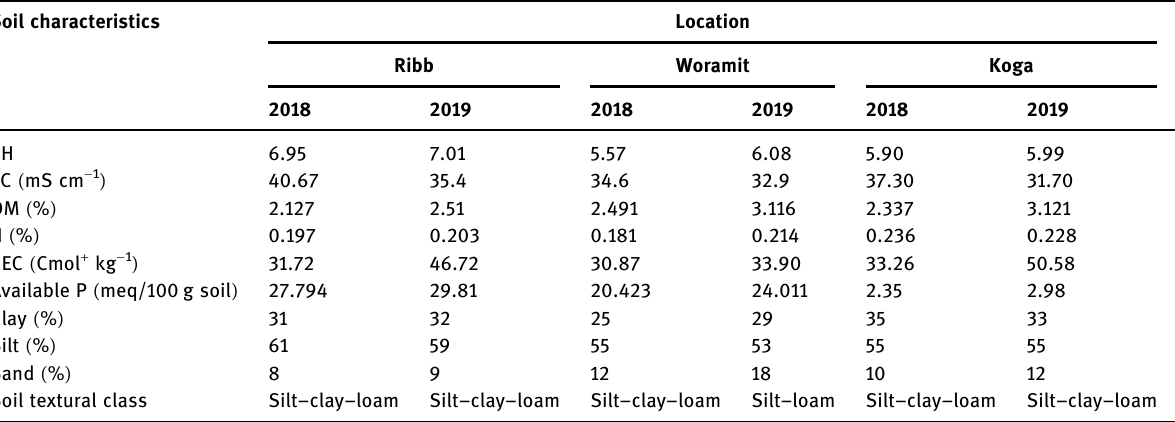
Table 1: Soil physical and chemical properties of the experimental sites Soil